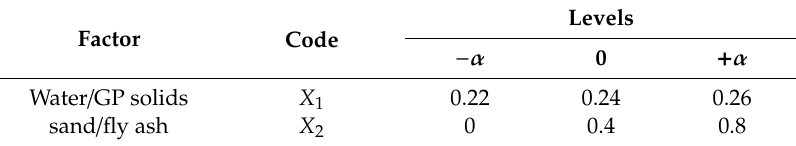
Table 5. Boundaries of factors in response surface methodology